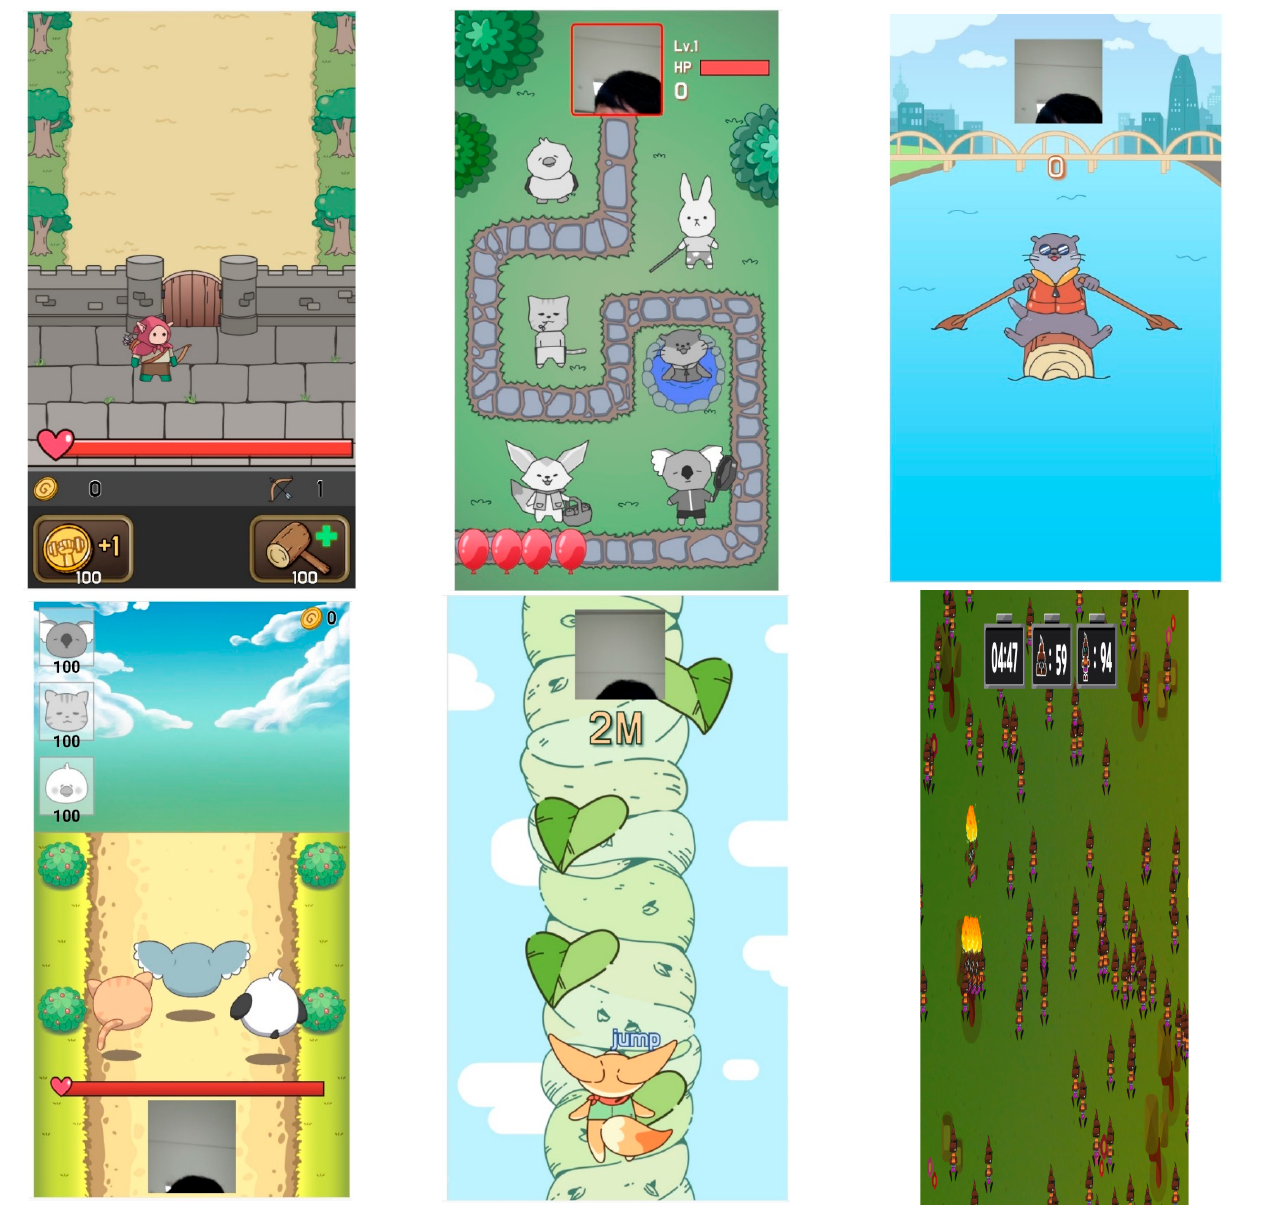
Figure 2. Metaverse rehabilitation game.